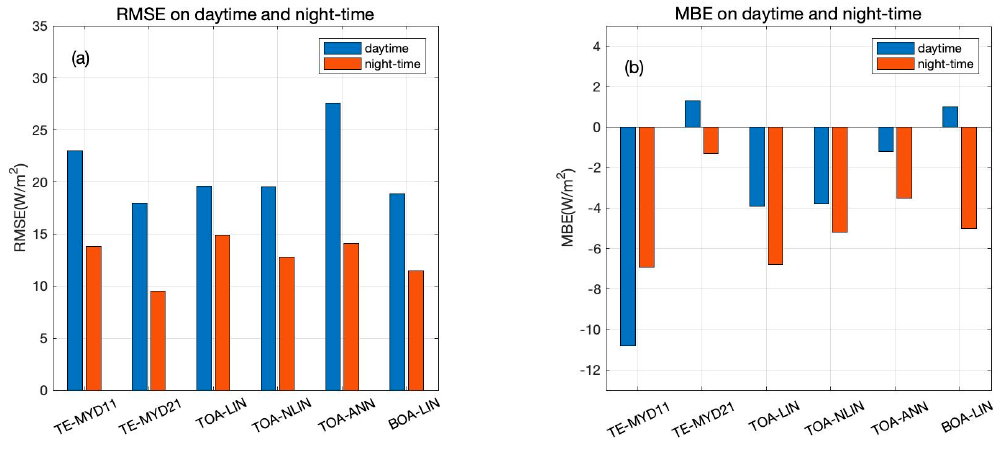
Figure 6. Histograms for daytime and night-time RMSE and MBE of the in situ measurement data. ( a ) RMSE. ( b ) MBE.